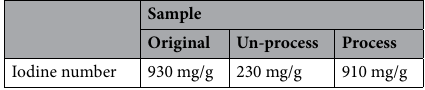
Table 5. Results of iodine number